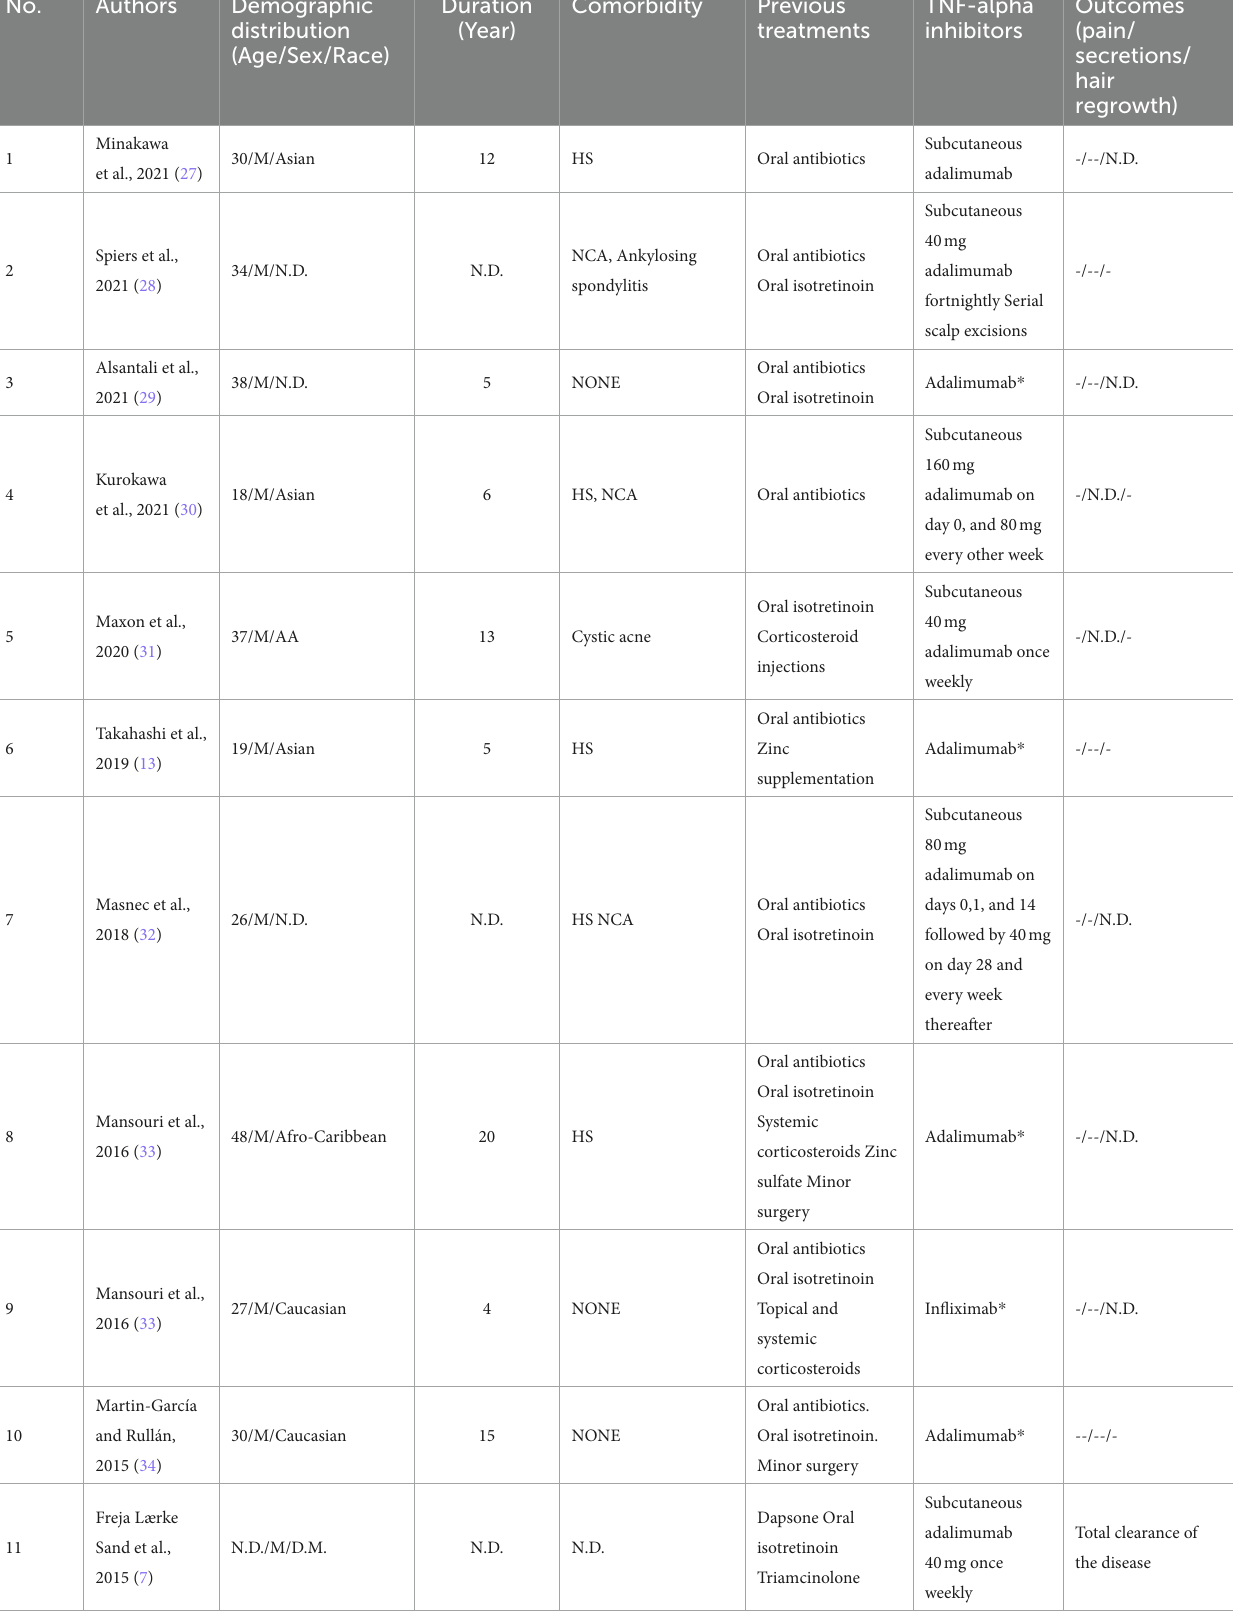
TABLE 1 Clinical characteristics of PCAS patients treated with tumor necrosis factor inhibitors.